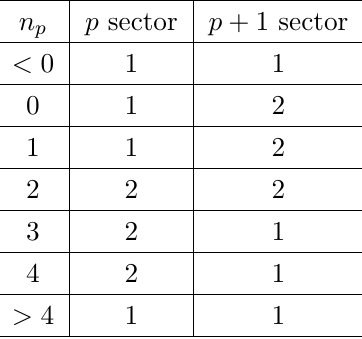
Table 1 . The number of independent normalizable modes for p and p +1 form sector. n p = d − 2 p − 1 . and ψ